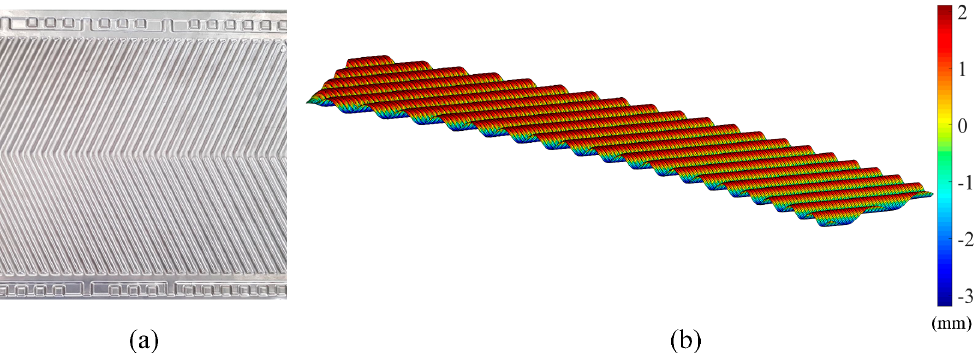
Figure 10. ( a ) The chevron-corrugated plate; ( b ) part of the measurement data.